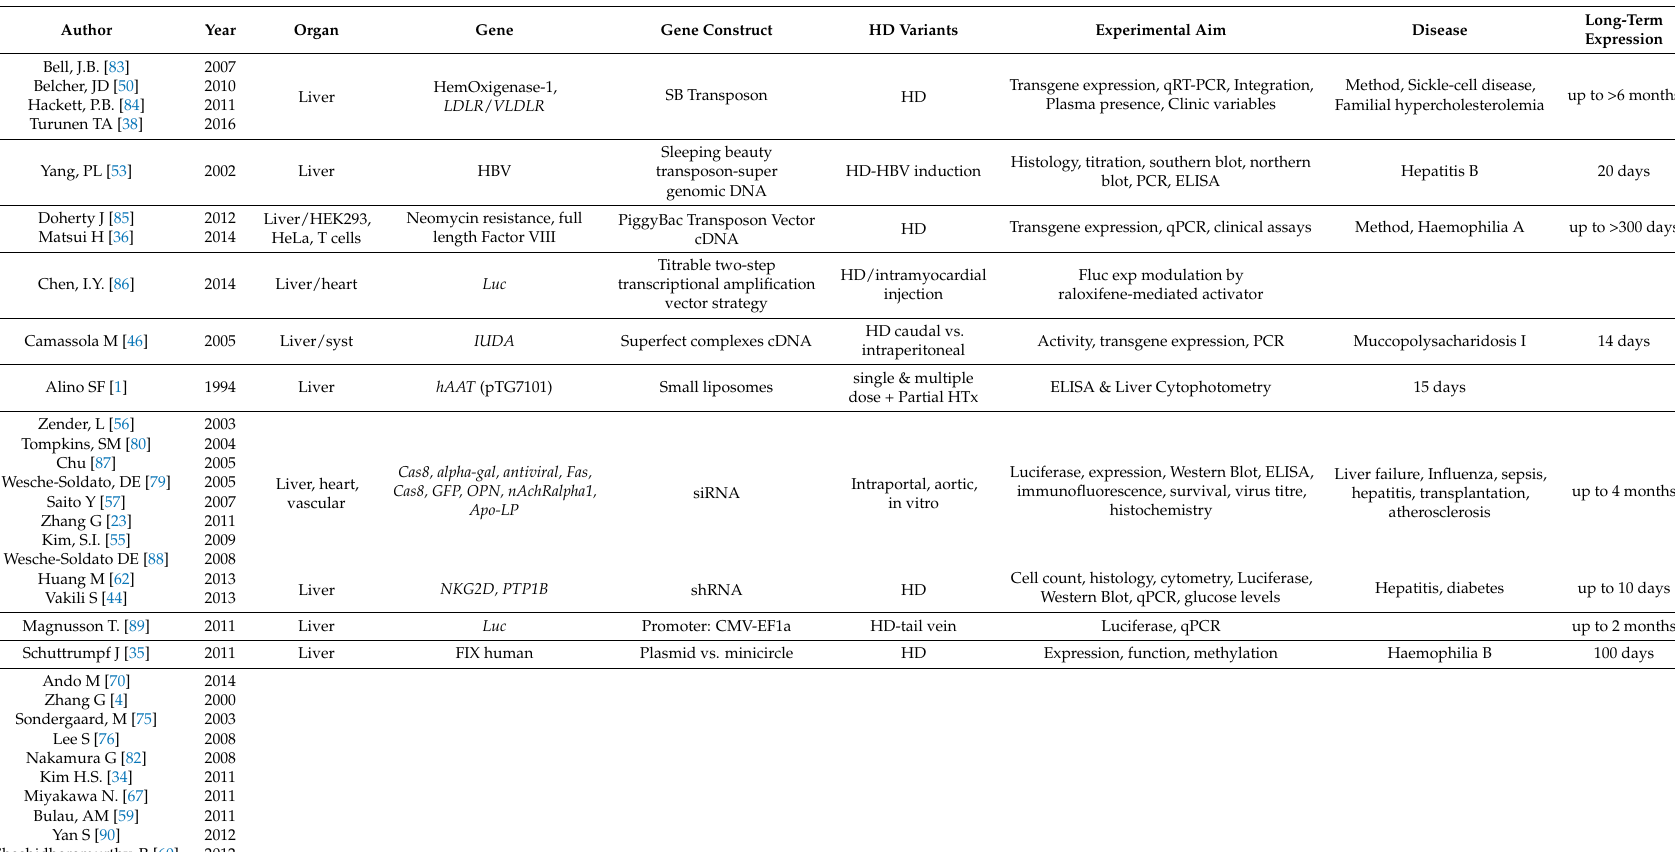
Table 1. Hydrodynamic gene transfer works performed in murine model. The table shows the author of each work, the publication year, the target organ assayed, gene and gene construction, conditions of hydrodynamic injection, experimental aim and methodology, disease of interest and effect duration.